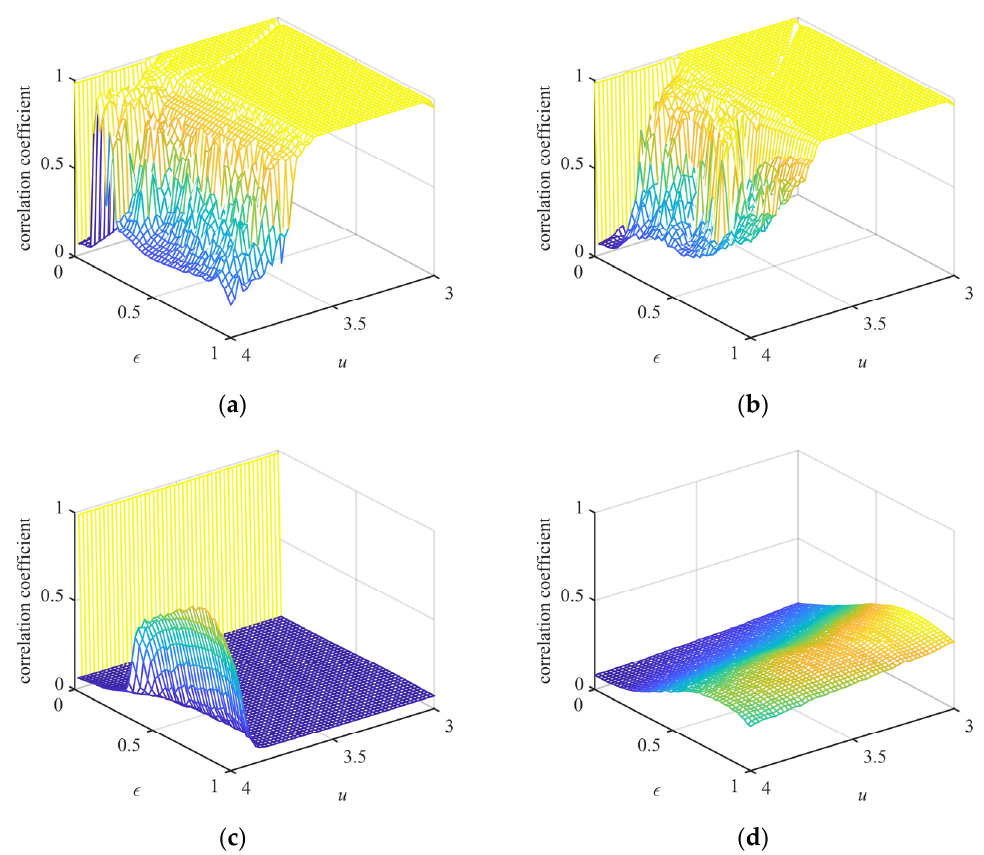
Figure 9. The correlation analysis of ( a ) 2D-CML, ( b ) 2D-NLCML, ( c ) 2D-MCPML and ( d ) 2D-DPRCML.